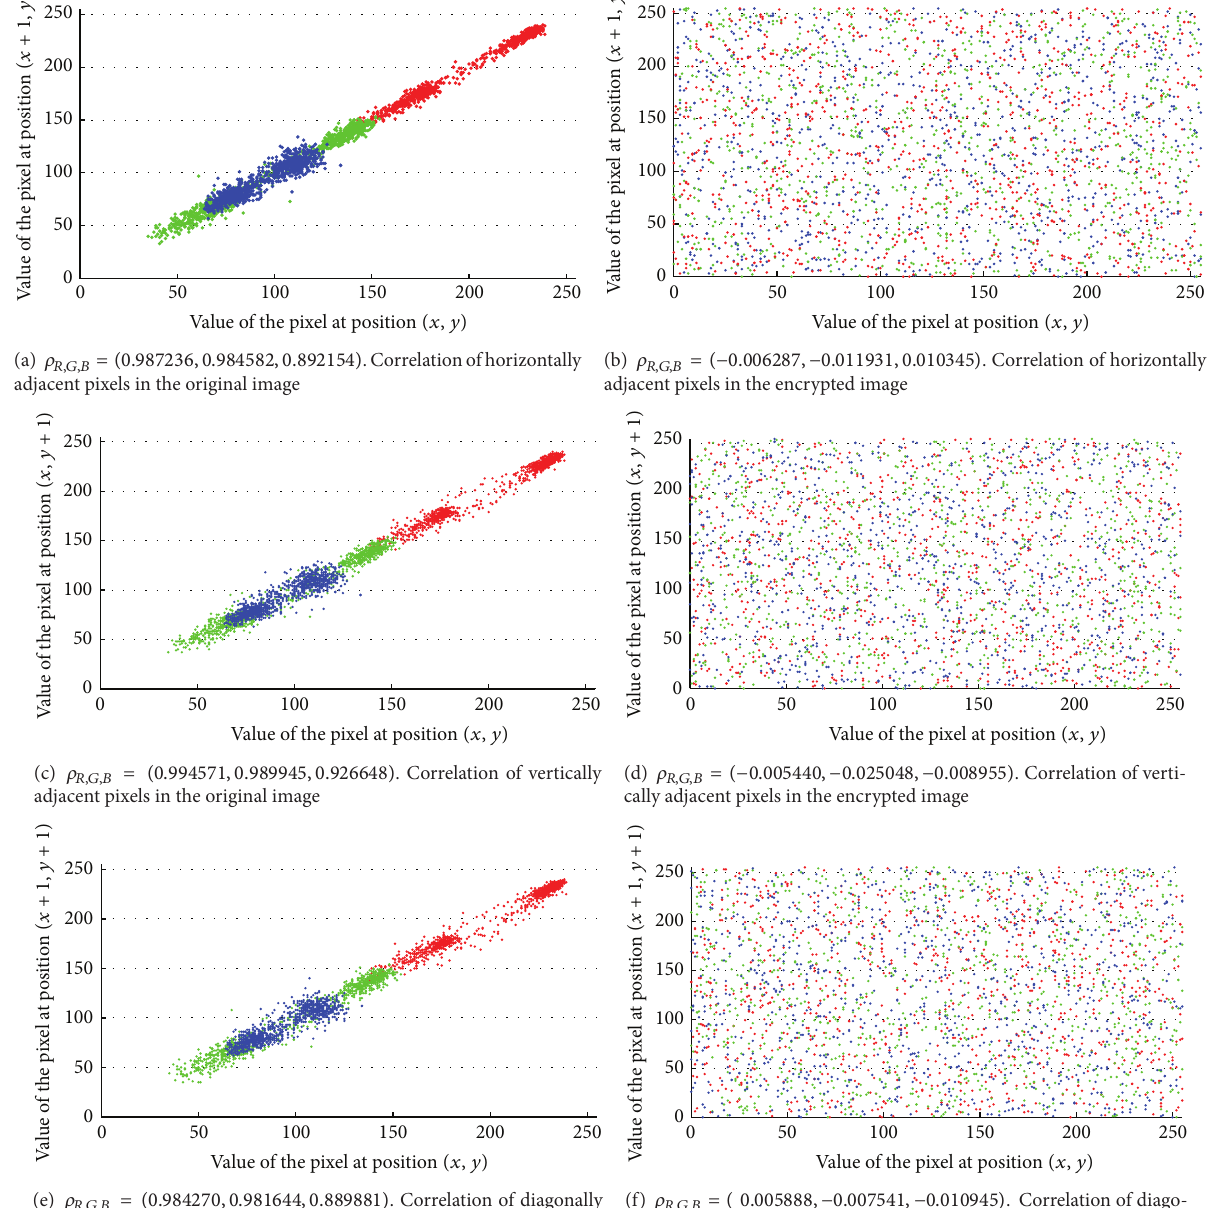
Figure 10: Correlation of adjacent pixels from Lena plain/encrypted